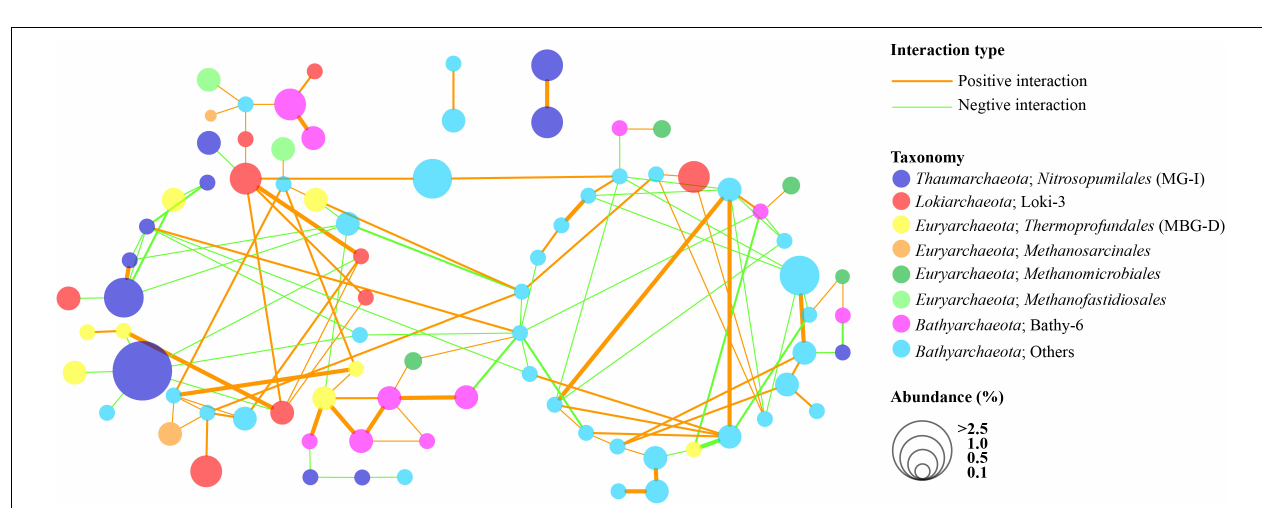
FIGURE 6 | Differential distributions of the subgroups of Bathyarchaeota (A) , and Thaumarchaeota , Euryarchaeota , and Lokiarchaeota (B) in a Group A (low-salinity) and Group B (relatively high salinity) based on logarithmic LDA scores. The color of the squares indicates the abundance of OTUs.